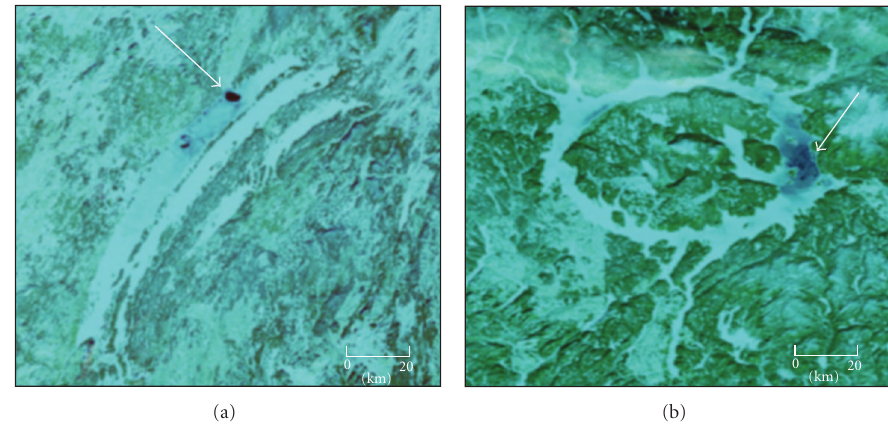
Figure 4: Small areas of open water detectable by MODIS but not IMS, highlighted by the white arrows for (a) L. Mistassini, January 8, 2010 (IMS CFO = January 4, MODIS CFO = January 20) and (b) Manicouagan R., February 9, 2010 (IMS CFO = January 4, MODIS CFO = February 25). Locations highlighted in Figure